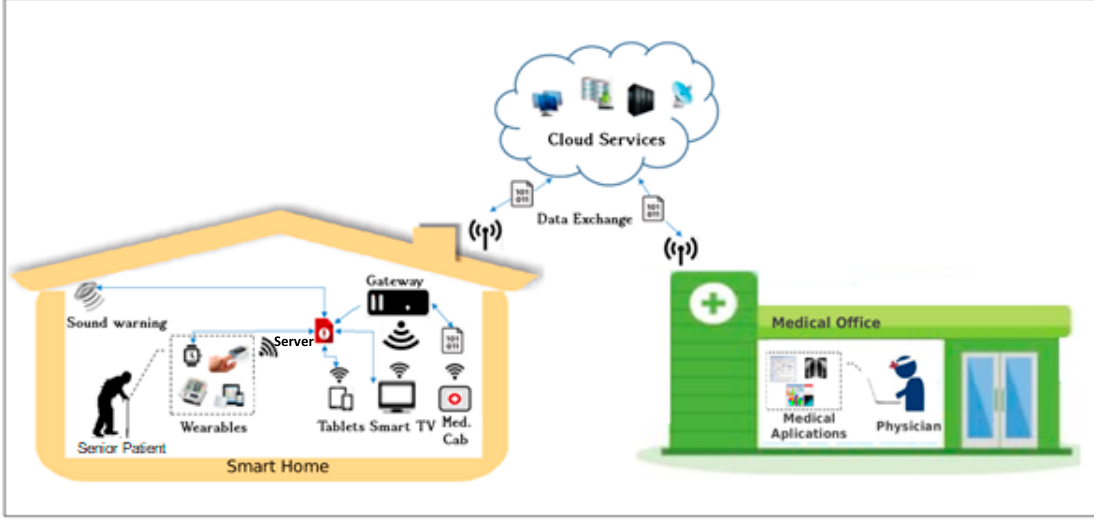
Figure 1. Overview of the system. The scenery is divided into two parts, the smart home and the medical o ffi ce; they are connected by the cloud infrastructure.